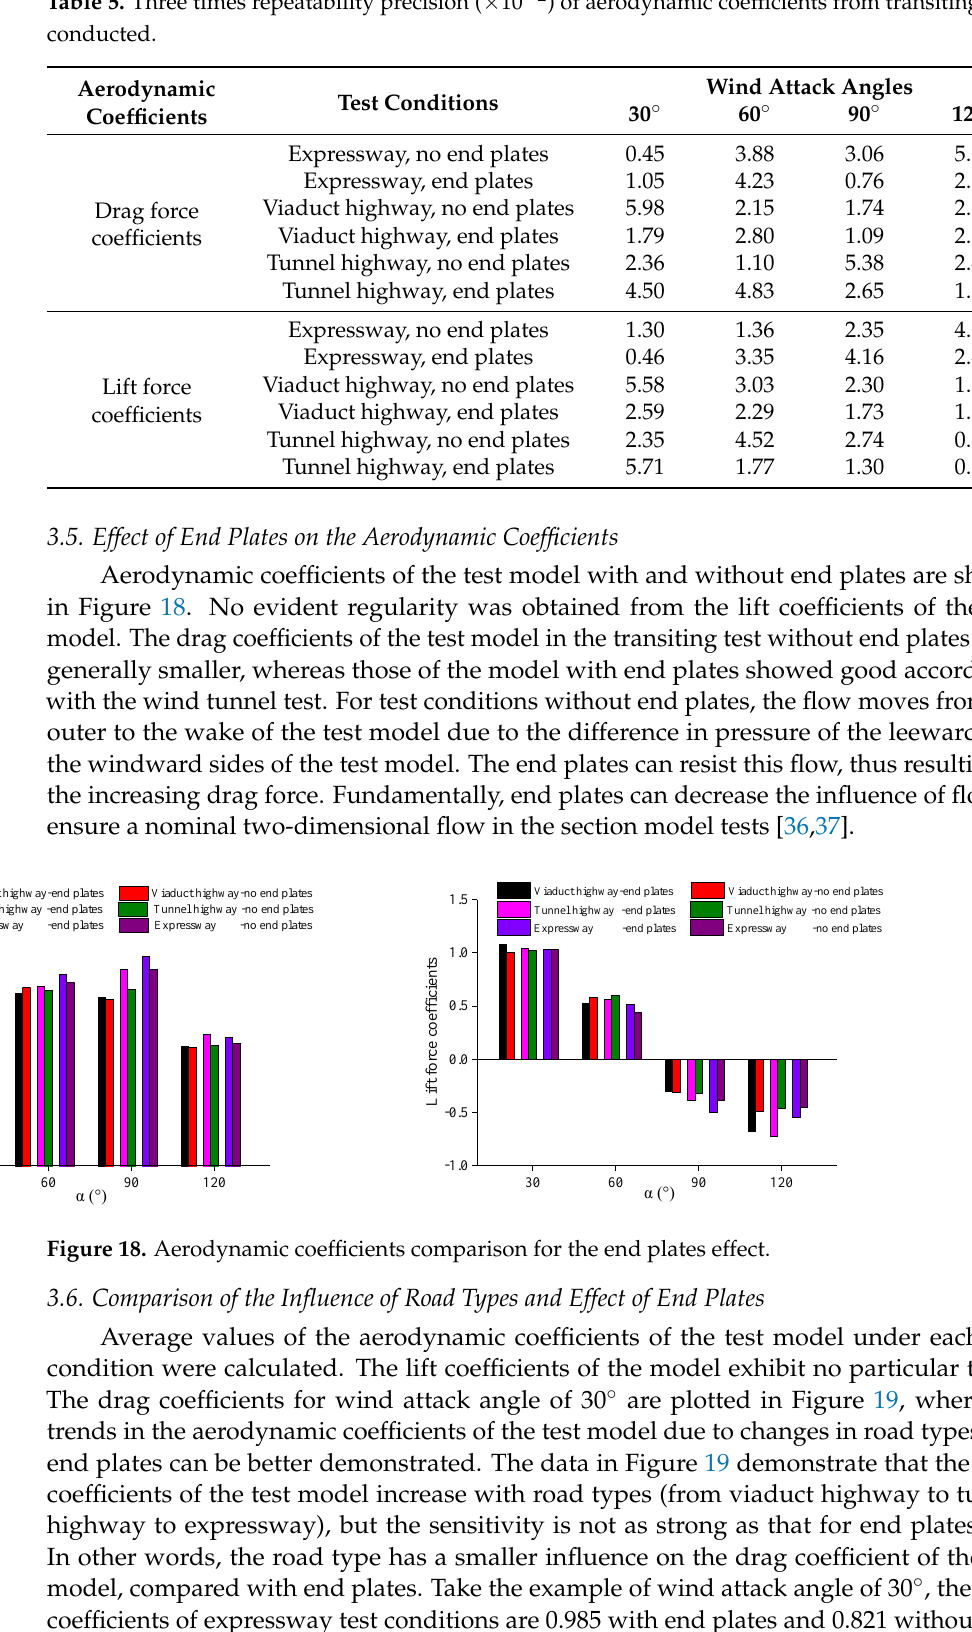
Figure 19. Aerodynamic coefficients of the model at the wind attack angle of 30°, with changes in road types and end plates. 4. Conclusions This paper mainly investigates the influence of road types on the transiting test for aerodynamic coefficient measurements: expressway, viaduct highway, and tunnel high- way. The following remarks can be concluded from the experimental tests: